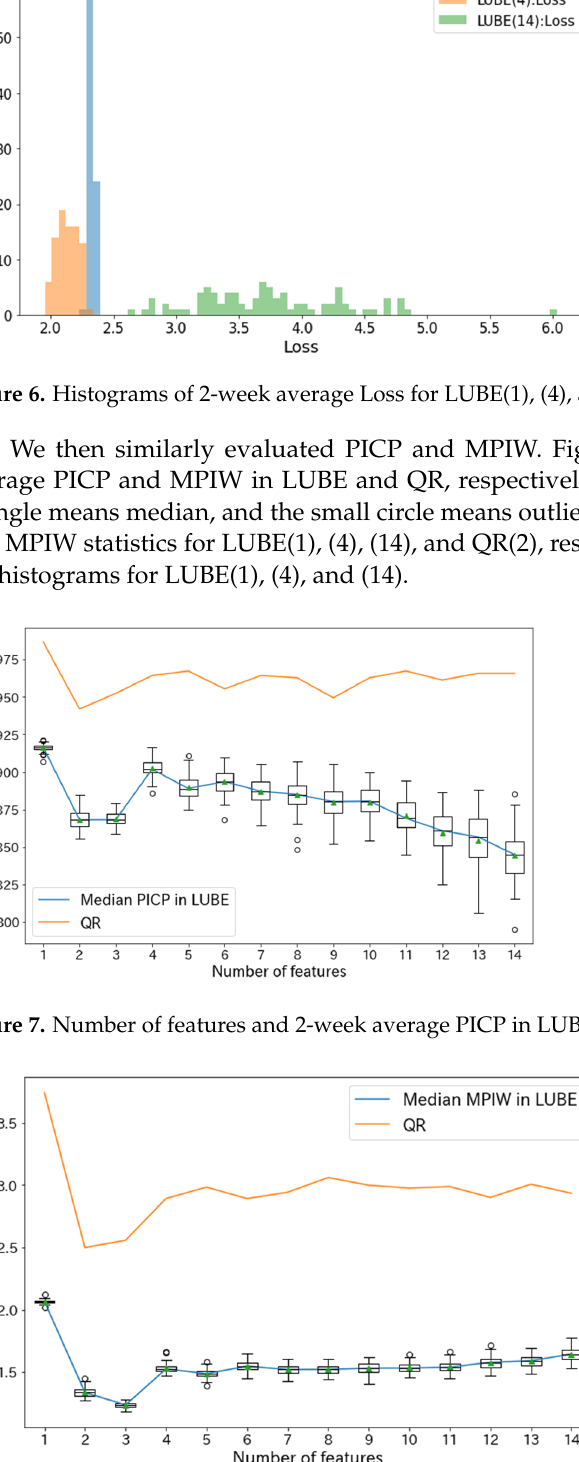
Figure 8. Number of features and 2-week average MPIW in LUBE and QR.